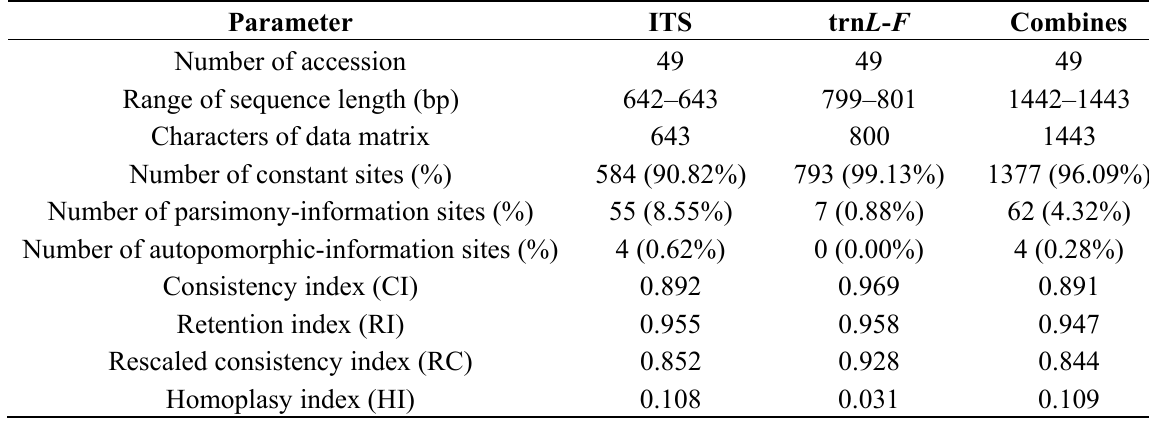
Table 1. Comparison of Phylogenetic Information for Atractylodes Species from internal transcribed spacer (ITS), trn L - F , and combines data